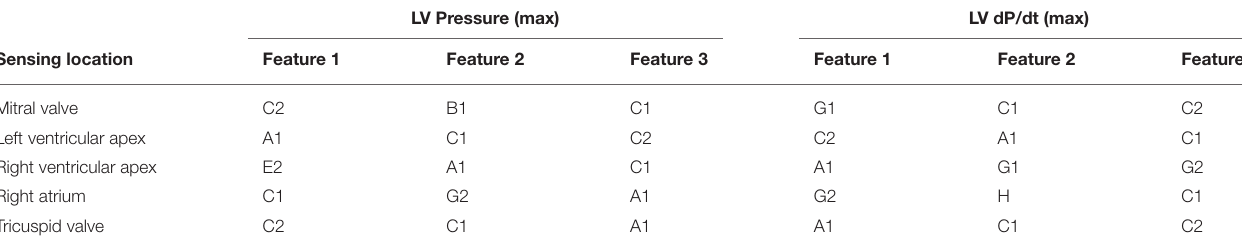
TABLE 4 | Most relevant features according to their re-occurrence when generating accuracy optimized models. LV Pressure (max) LV dP/dt